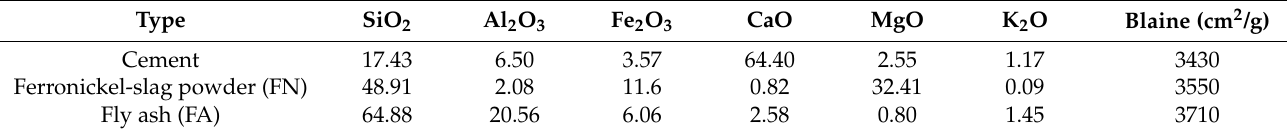
Figure 2. SEM images of sample: ( a ) fly ash, ( b ) ferronickel-slag powder. Table 1. Chemical composition of cementitious materials.